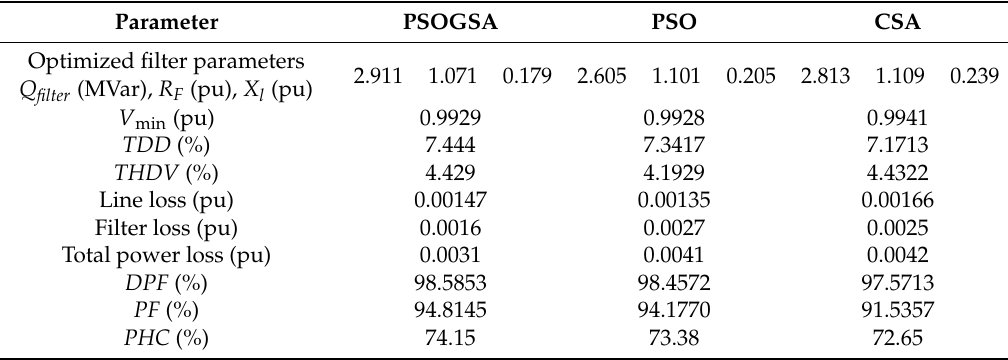
Table 4. Operational parameters and PHC results that are obtained using the designed filters.